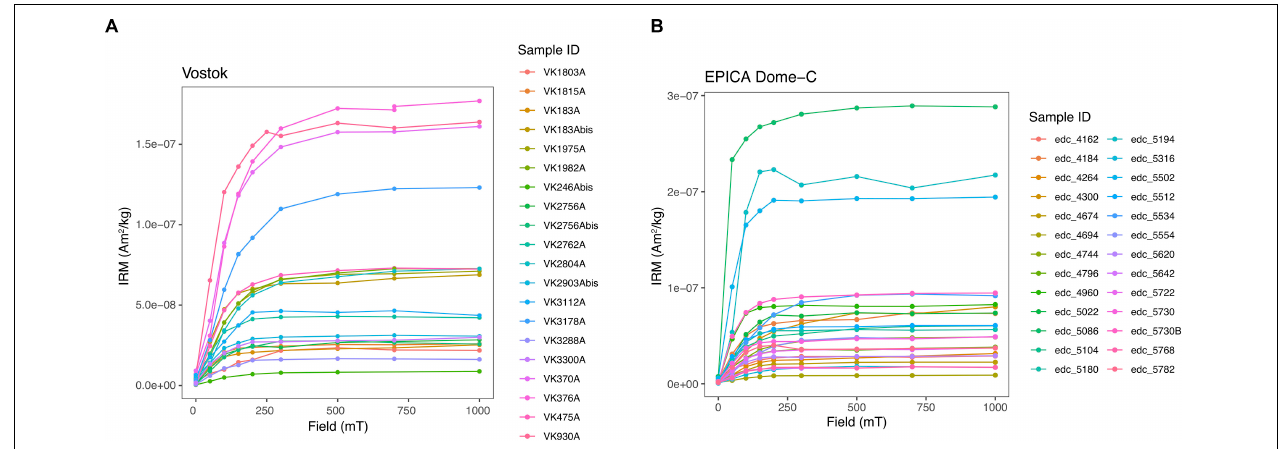
FIGURE 2 | IRM acquisition of ice samples from (A) Vostok and (B) EPICA Dome-C ice cores. IRM is measured at 100 K and expressed as magnetic moment per unit of mass of the whole ice samples. Therefore this is the magnetization of the dust diluted within the ice. IRM acquisition curves are of good quality considering the extremely low intensity of the ice magnetization and testify to the reliability of the